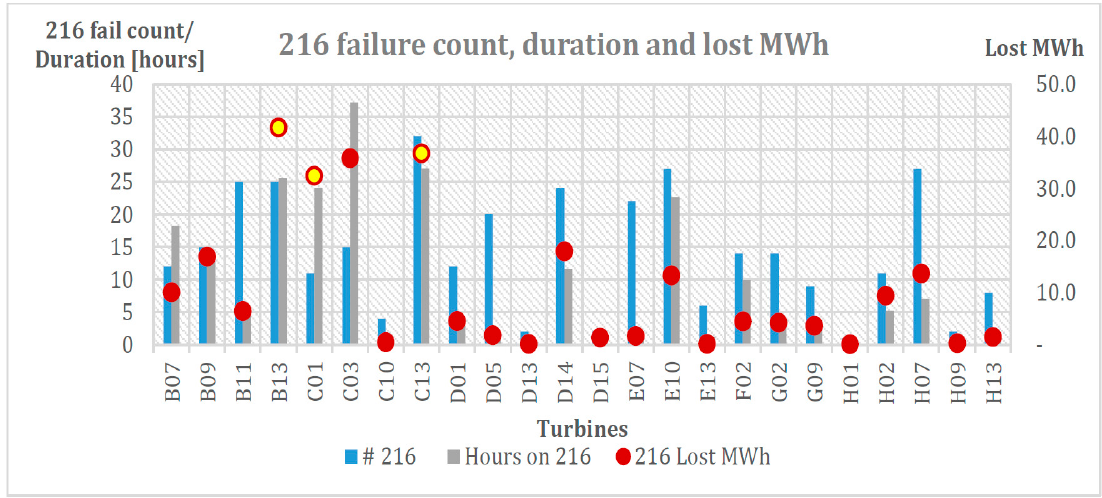
Figure 4. Historical Settlement Point Price 2017–2018Q1 [25].